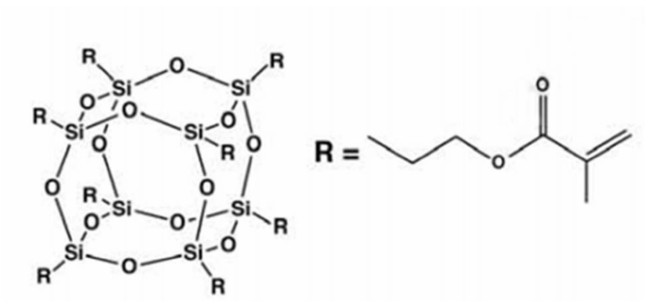
Figure 1. The molecule structure of methacryl polyhedral oligomeric silsesquioxane